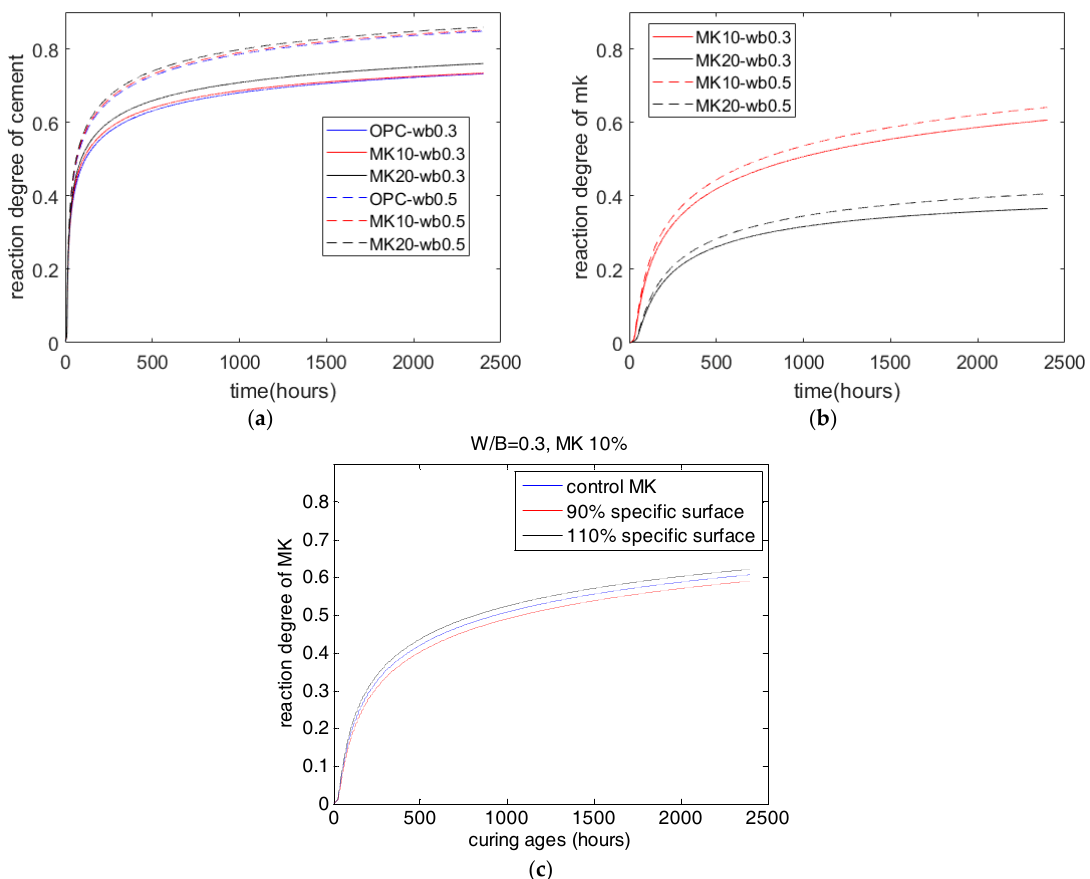
Figure 4. Parameter studies of the reaction degree of binders. ( a ) reaction degree of cement; ( b ) reaction degree of MK; and ( c ) effect of specific surface on reaction degree of MK.